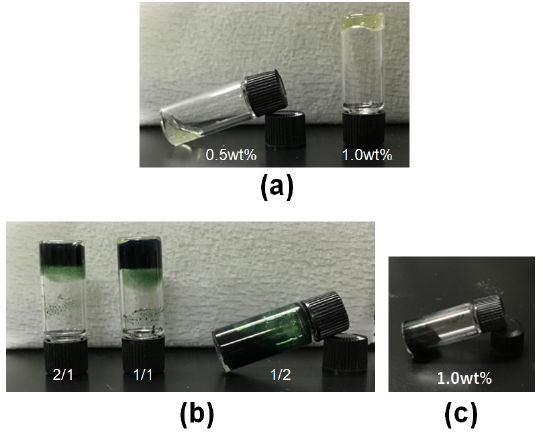
Figure 1. Photos of gelation test: ( a ) NaPPDT aqueous solutions in vials, ( b ) 1.0 wt% NaPPDT /1.0 wt% PAPA aq. mixed in vials, and ( c ) 1.0 wt% PAPA aq.